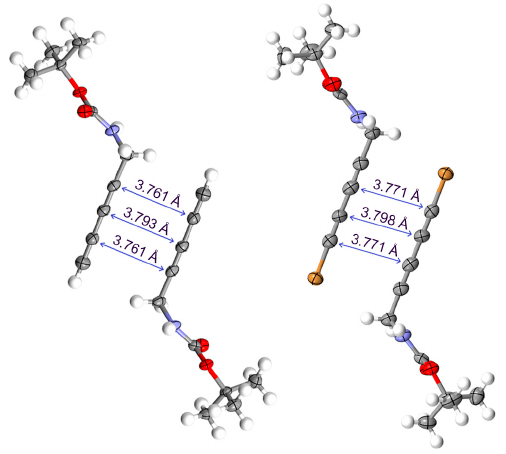
Figure 4. Geometrical characteristics of the closest parallel diyne rods in crystals of 1 and 2 .